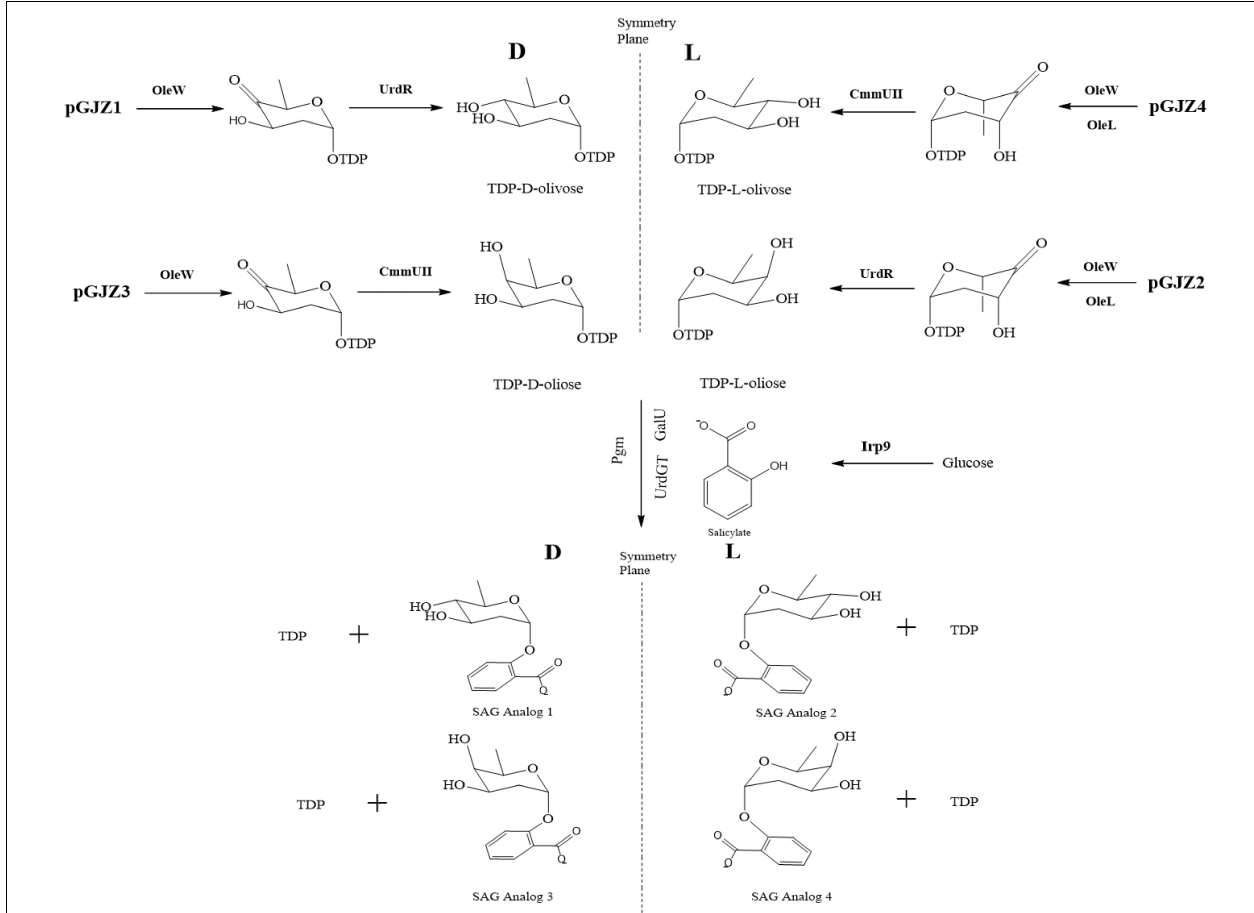
FIGURE 3 | Biosynthetic pathways for the production of SAG analogs. pGJZ plasmids 1–4 encode pairs of chiral-symmetric olivose and oliose deoxysugars to glycodiversify salicylate.